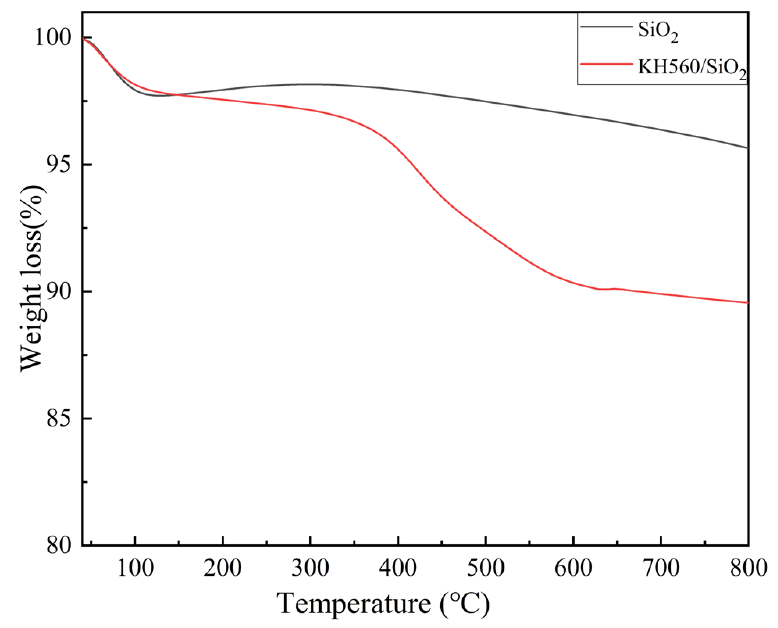
Figure 3. TGA curves of SiO 2 and KH560/SiO 2 .